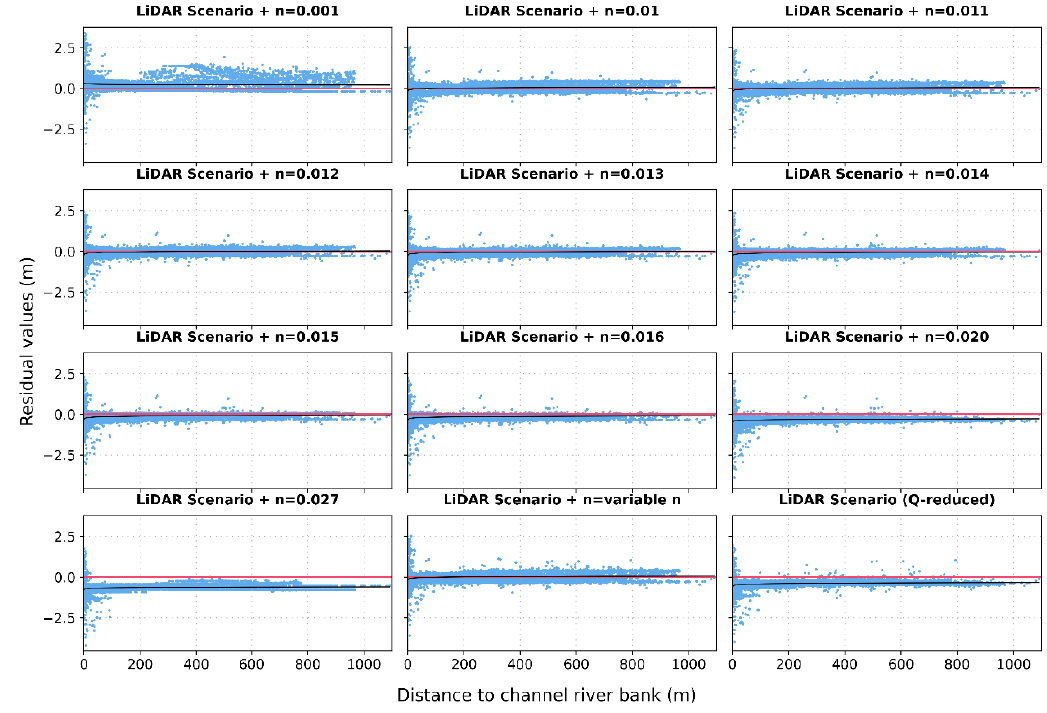
Figure 6. Scatter plot graphical representation of the relationship between the variable flow depth and distance to the riverbank for different Manning ’ s n value calibrated models. The red line shows an error equal to zero and the black line shows a logarithmic fitting to the point values.